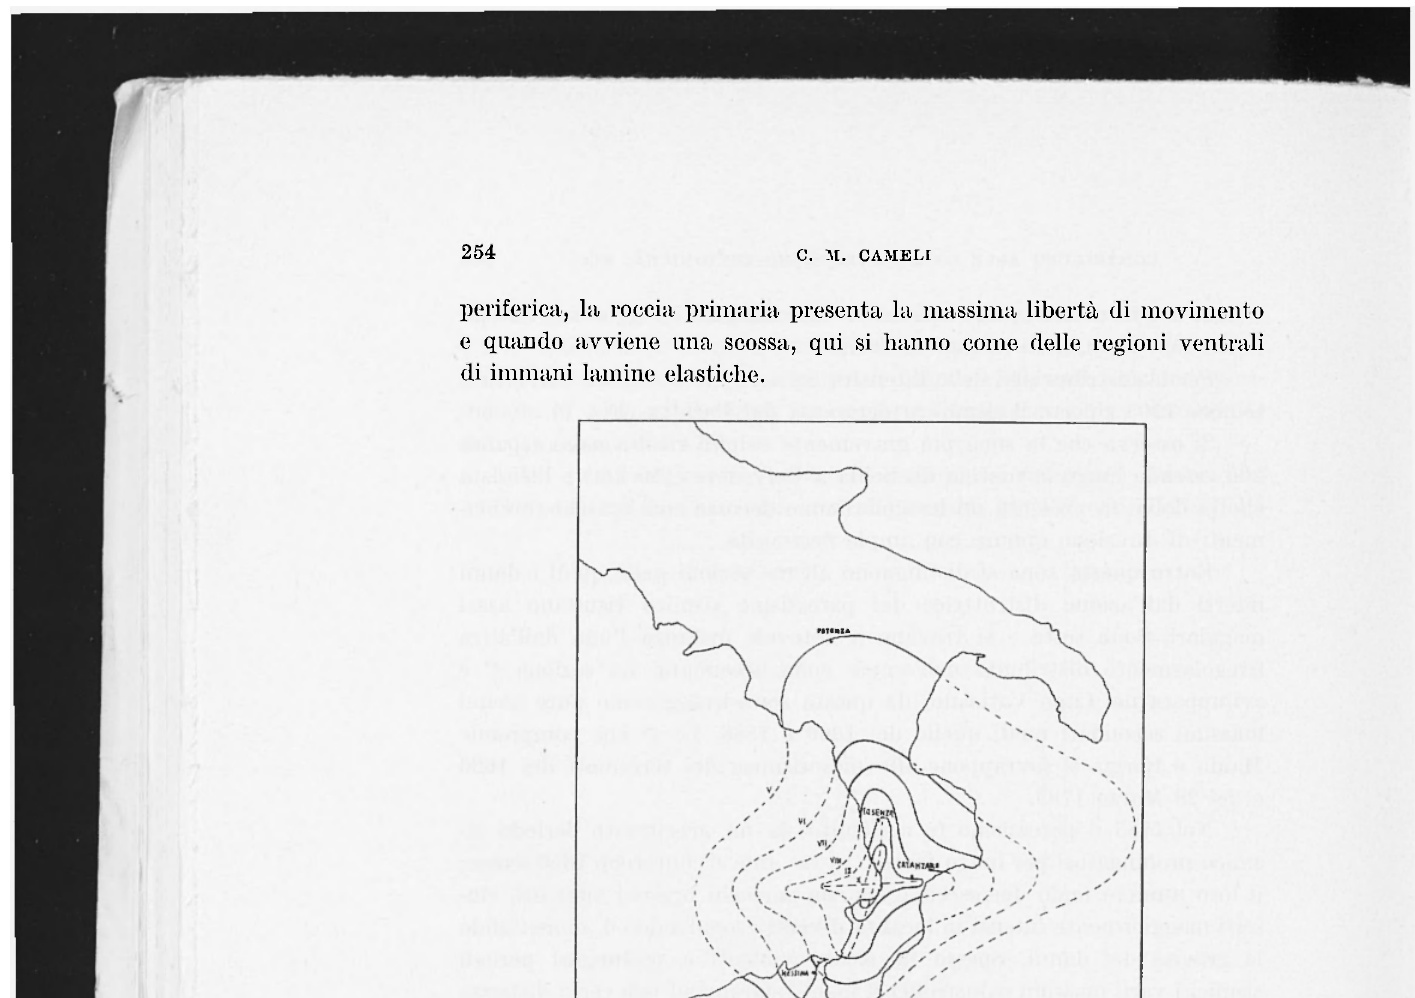
Fig. 6 - Isosisme del terremoto Calabro dell'8 Settembre 1905 (secondo G. B.